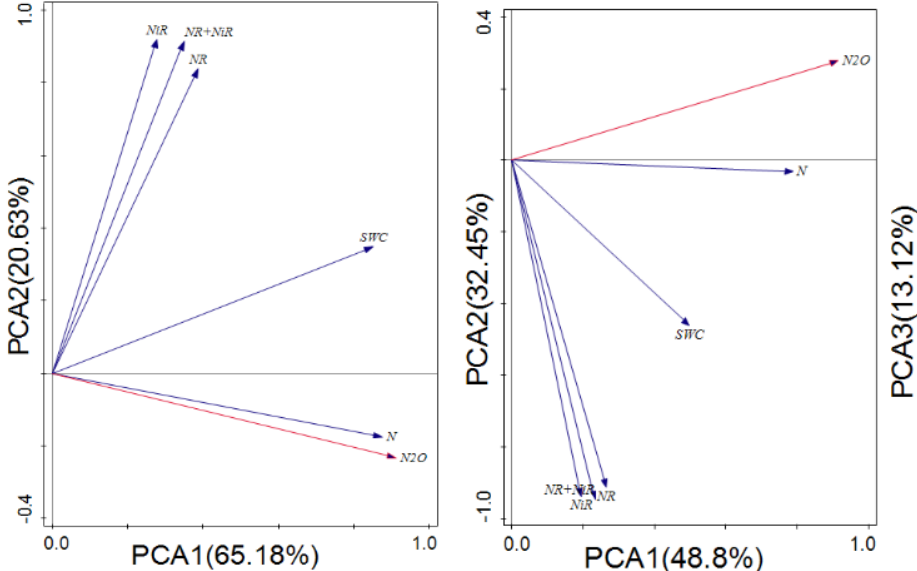
Figure 5. Principal component analysis (PCA) of N 2 O emission flux with different indexes under RF and TF. Note: The left is TF, the right is RF.